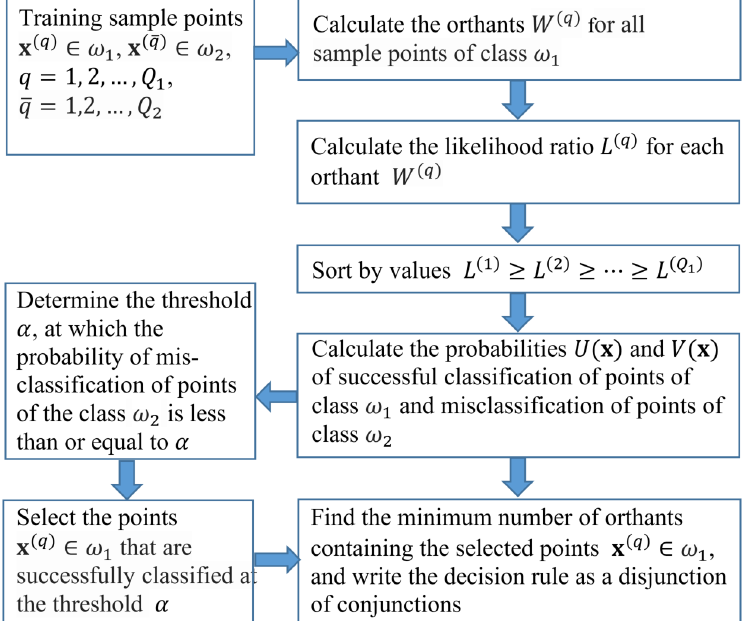
THEN the point x belongs to class ω 1 with probability U ( x ) = 7/8 and with probability V ( x ) = 2/12 belongs to class ω 2 .